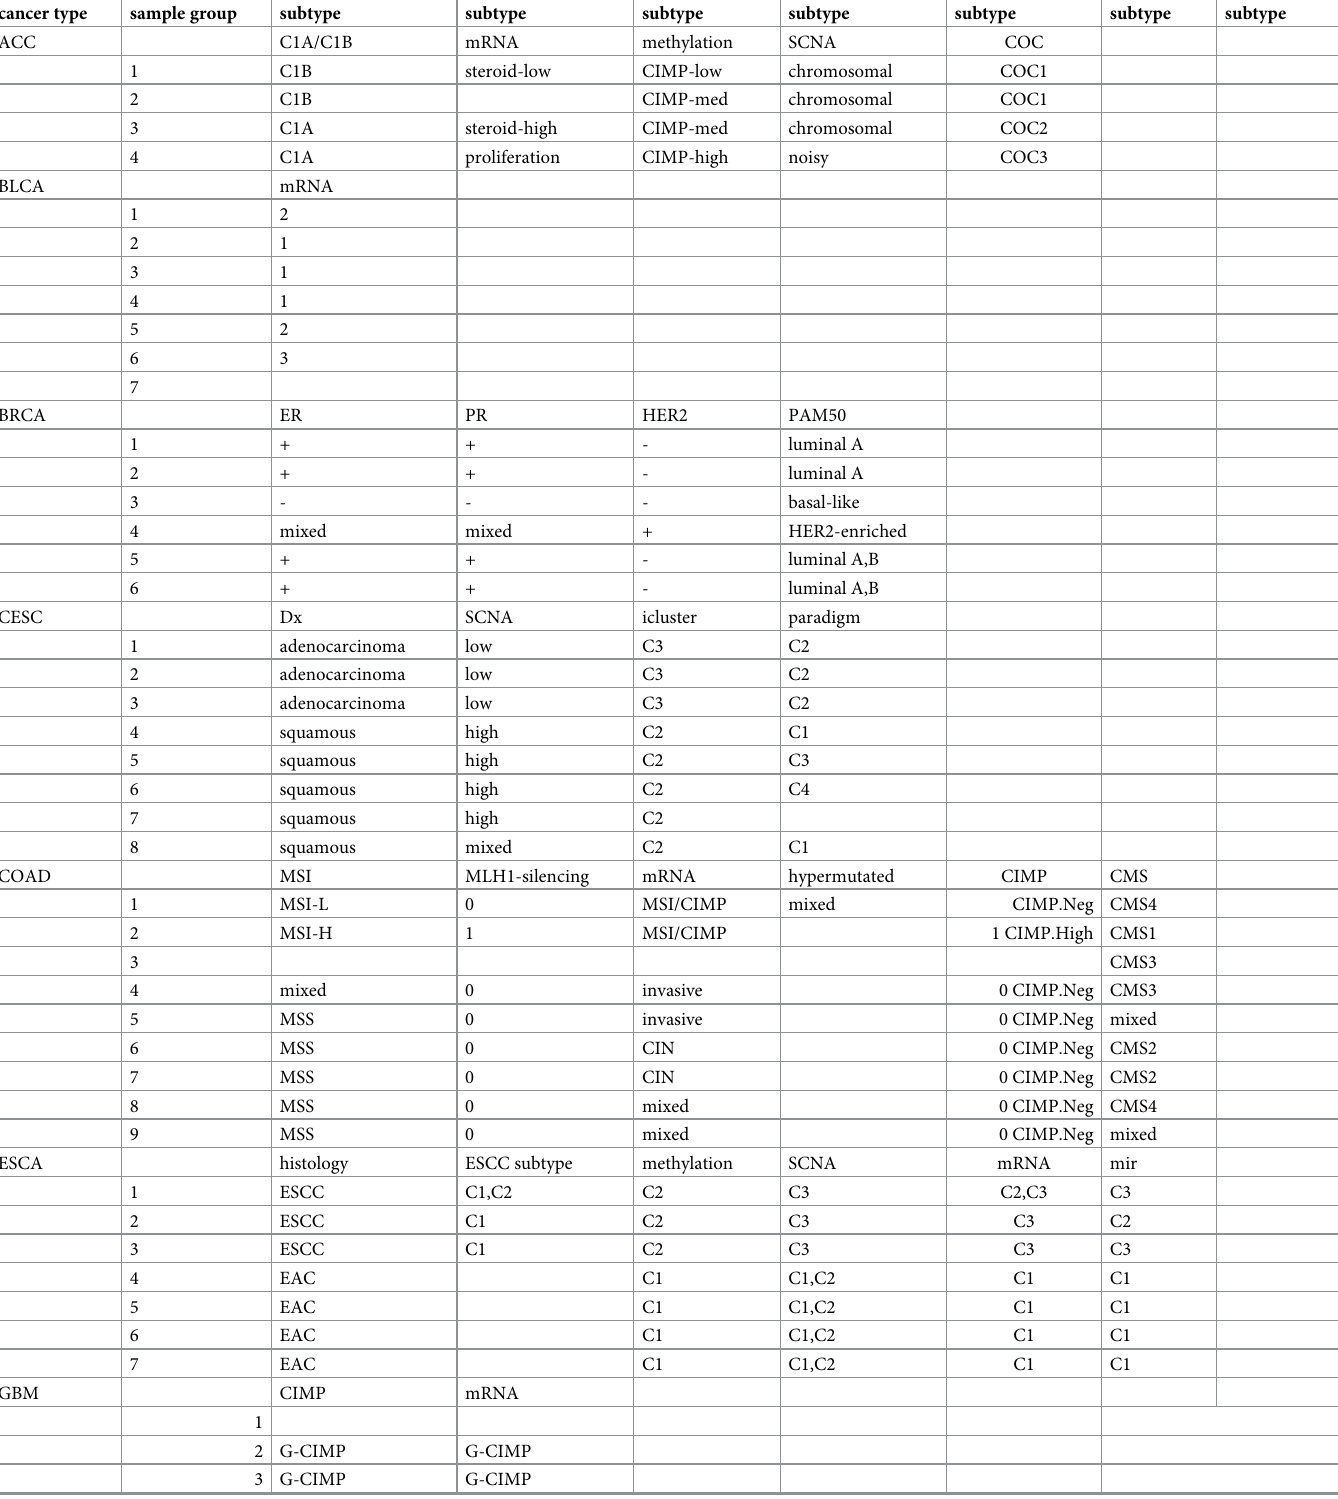
Table 5. Alignments of Sample Groups with clinical features within cancer types. For each cancer type, the representative values (features) of selected subtypes of each Sample Group are